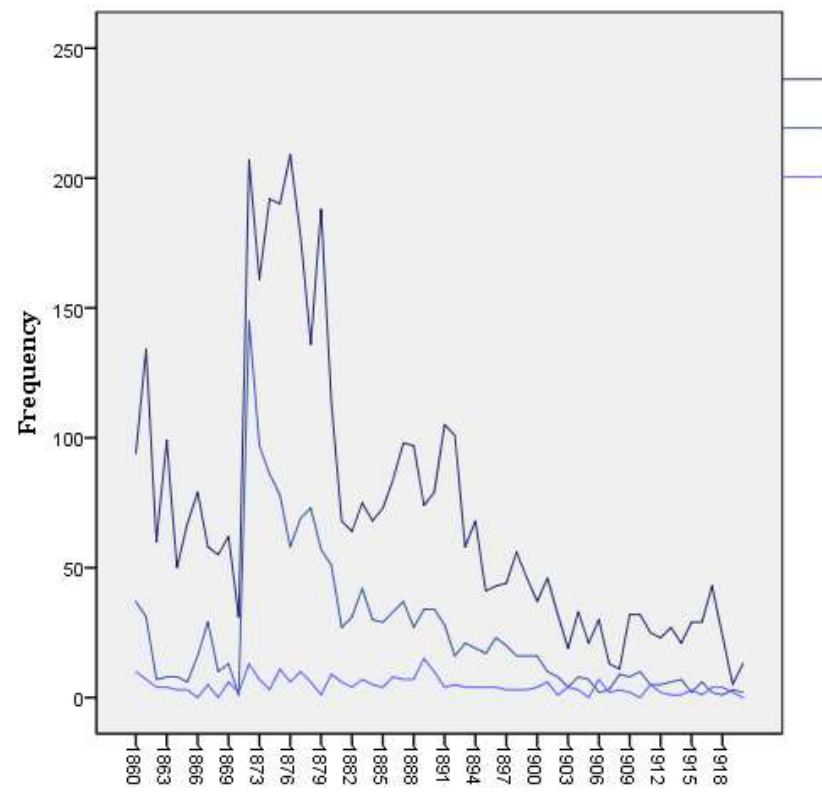
Figure 1: Year of women’s first imprisonment between 1860 and